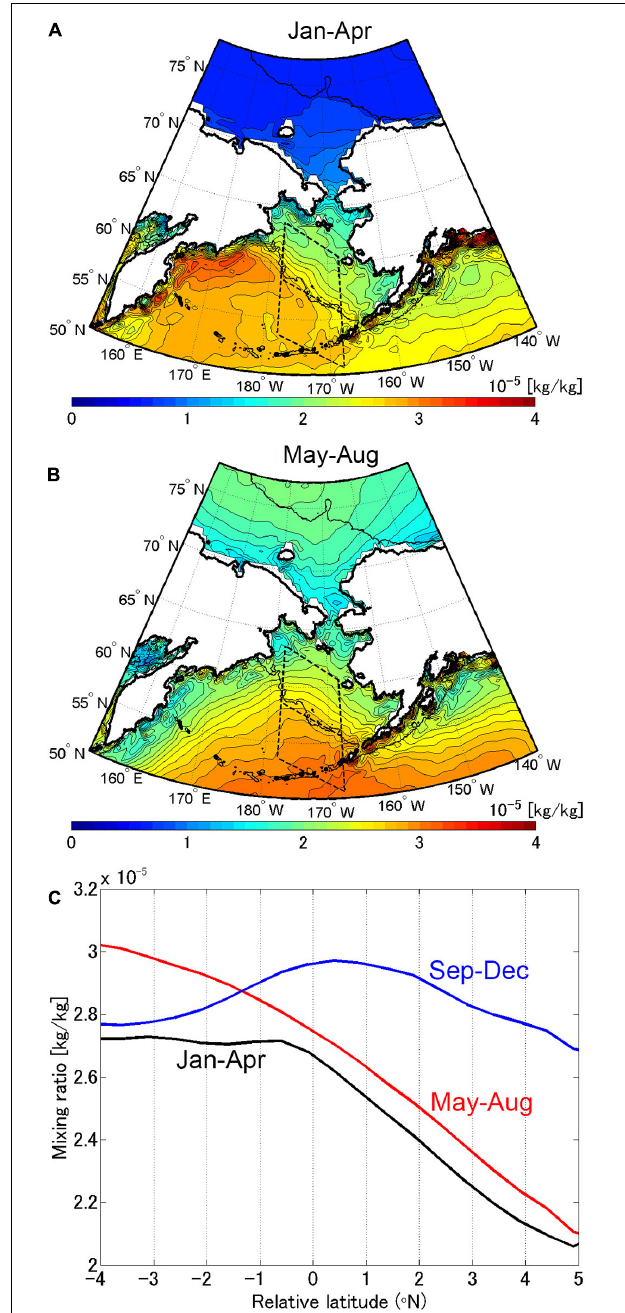
FIGURE 8 | Climatology of the cloud water mixing ratio averaged between 700 and 1,000 hPa for (A) January to April and (B) May to August. (C) Cloud water mixing ratio from 700 to 1,000 hPa averaged over the black dashed box in (A,B) for January to April (black), May to August (red), and September to December